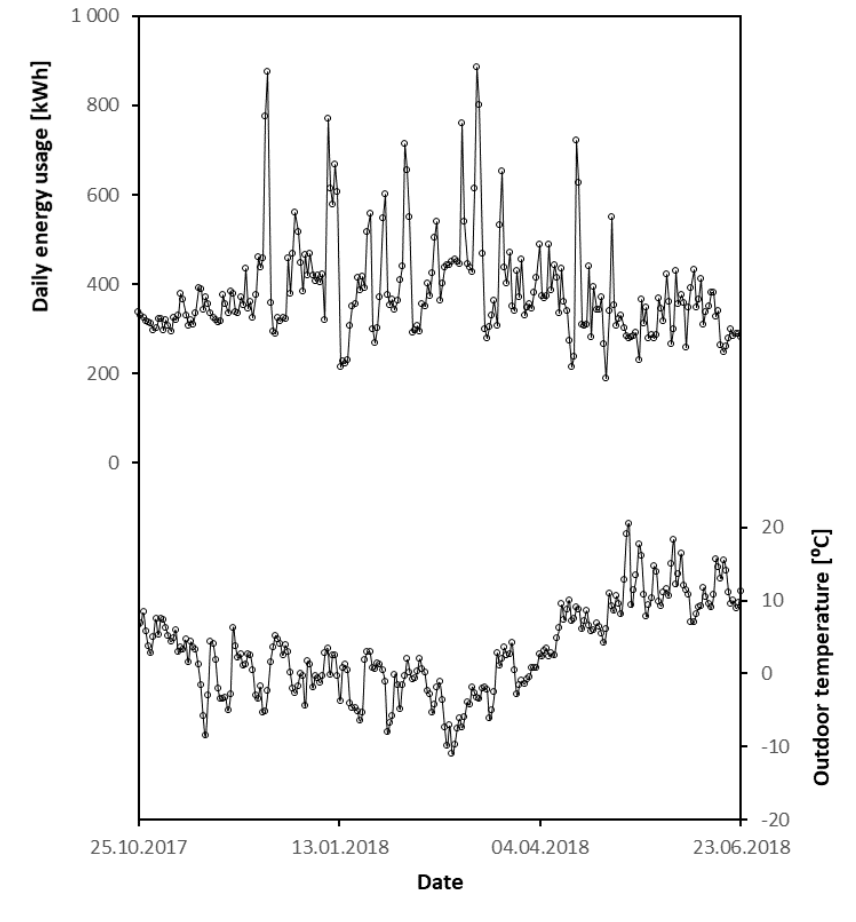
Figure 4. Energy usage for operation of the swimming facility vs. the outdoor temperature, both daily